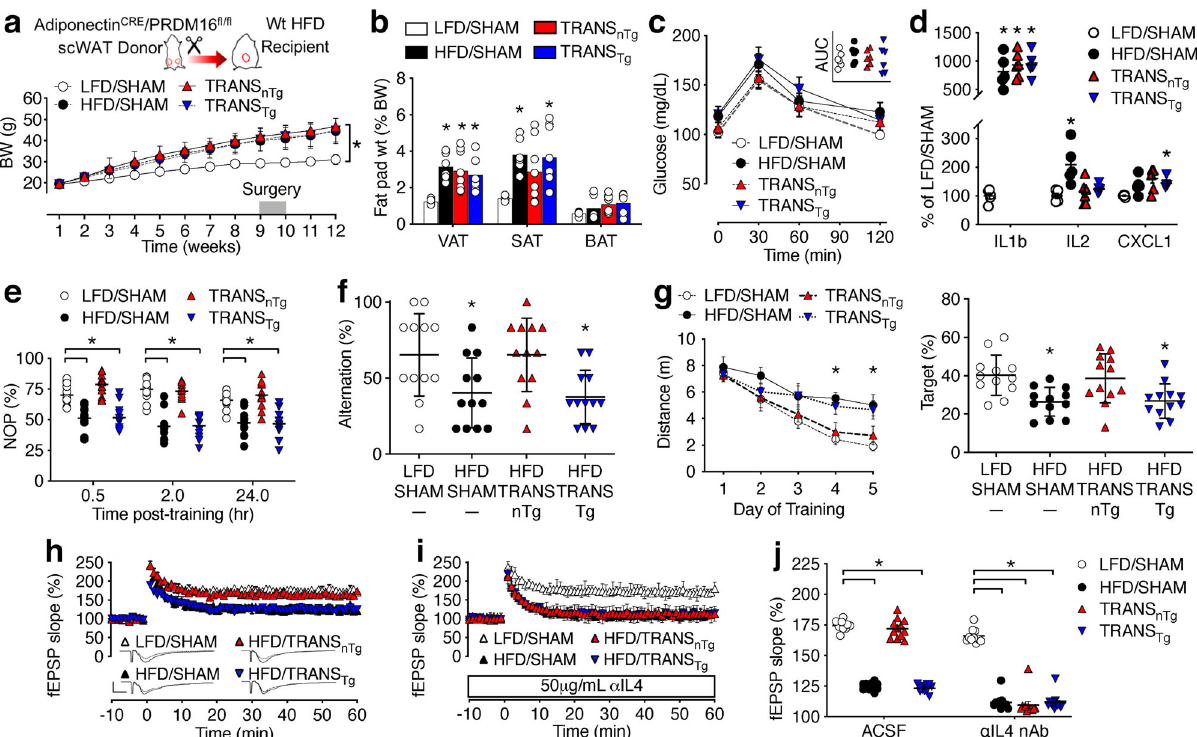
Fig. 3 Subcutaneous fat transplantation rescues hippocampal function in obese mice via beige fat-dependent mechanisms. a Weight gain in Wt mice maintained on a low-fat or high-fat diet (LFD, HFD), before and after sham operation (SHAM) or transplantation of subcutaneous fat from a nontransgenic (TRANS nTg ) or Adiponectin cre /PRDM16 fl / fl transgenic donor (TRANS Tg ). Symbols show group mean ± sem ( n = 24 mice/condition). b Comparable increases in the proportional weight of visceral and subcutaneous adipose tissue (VAT, SAT) relative to body weight (BW) in HFD/SHAM ( n = 6), TRANS nTg ( n = 8), and TRANS Tg mice ( n = 8), relative to LFD/SHAM ( n = 6); no change in brown adipose tissue (BAT). Bar height shows mean, error bars show sem, and symbols represent individual mice. c No signi fi cant differences in glycemic control, based on area under the curve (AUC, inset). Symbols represent mean ± sem of ( n = 7) mice/condition. For AUC (inset), symbols represent individual mice. d Dietary obesity increases serum pro-in fl ammatory cytokines (for TRANS nTg , n = 6; all other groups, n = 5). Symbols represent individual mice and the line shows mean ± sem. e SAT transplantation